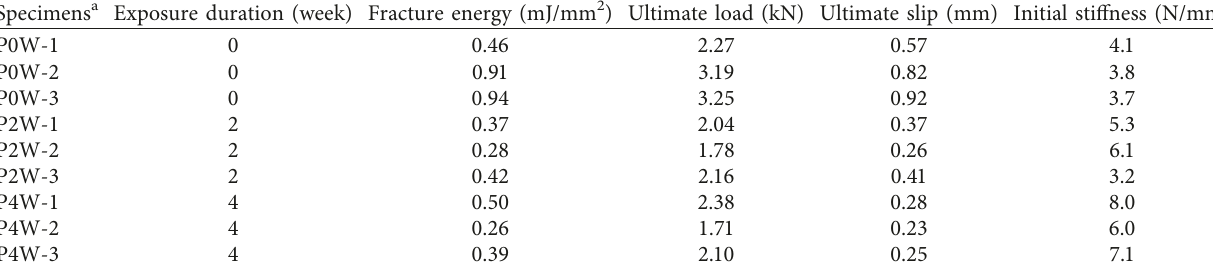
Figure 9: Typical load-deformation behavior of the four-point bending for control Table 2: Experimental program and main test result.